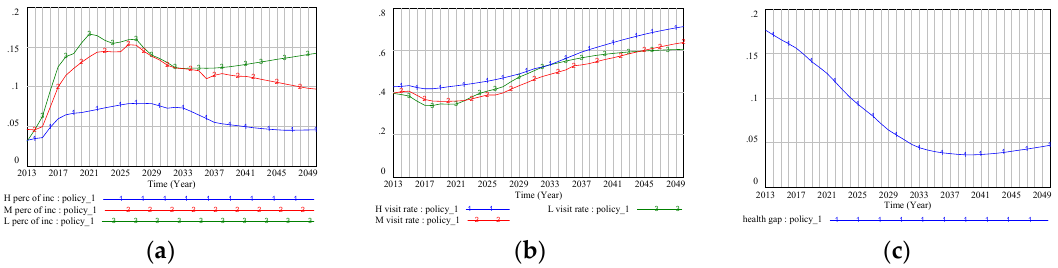
Figure 7. ( a ) Medical costs as a proportion of income (Policy Scenario 1); ( b ) doctor-visiting rate (Policy